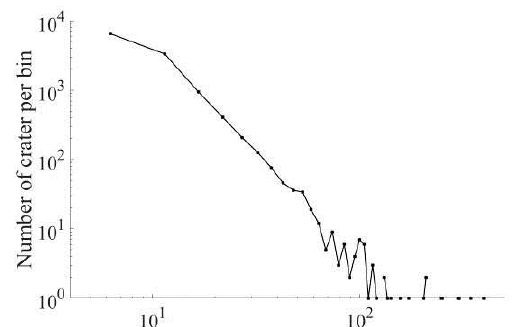
Figure 7. The size-frequency distribution of craters of CE-4 landing site on a log-log plot.